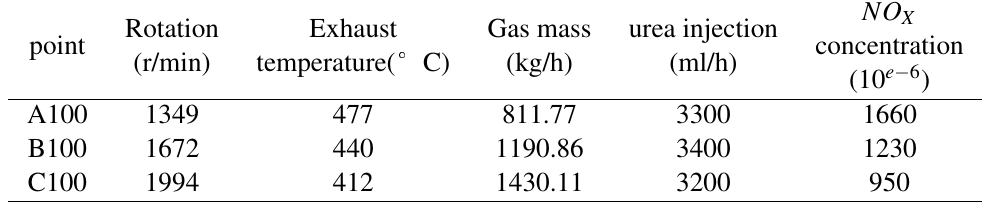
Table 1 Boundary condition of typical working